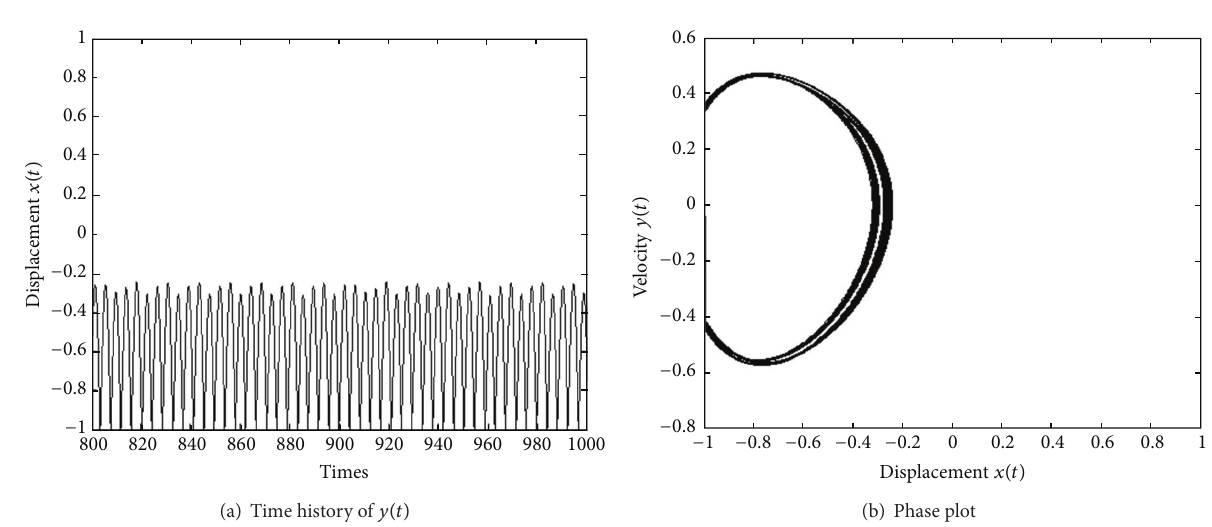
Figure 4: Numerical results of (1) ( 𝑓 1 = 2.5, 𝑓 2 = 0.05, 𝑥(0) = −0.8, ̇𝑥(0) = −2.5